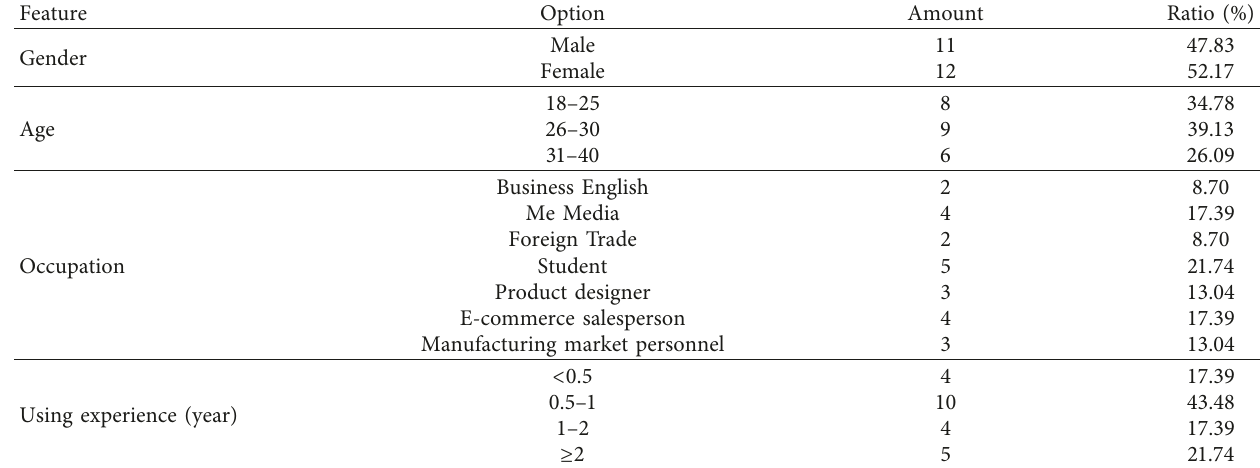
Table 2: Statistics of valid questionnaire